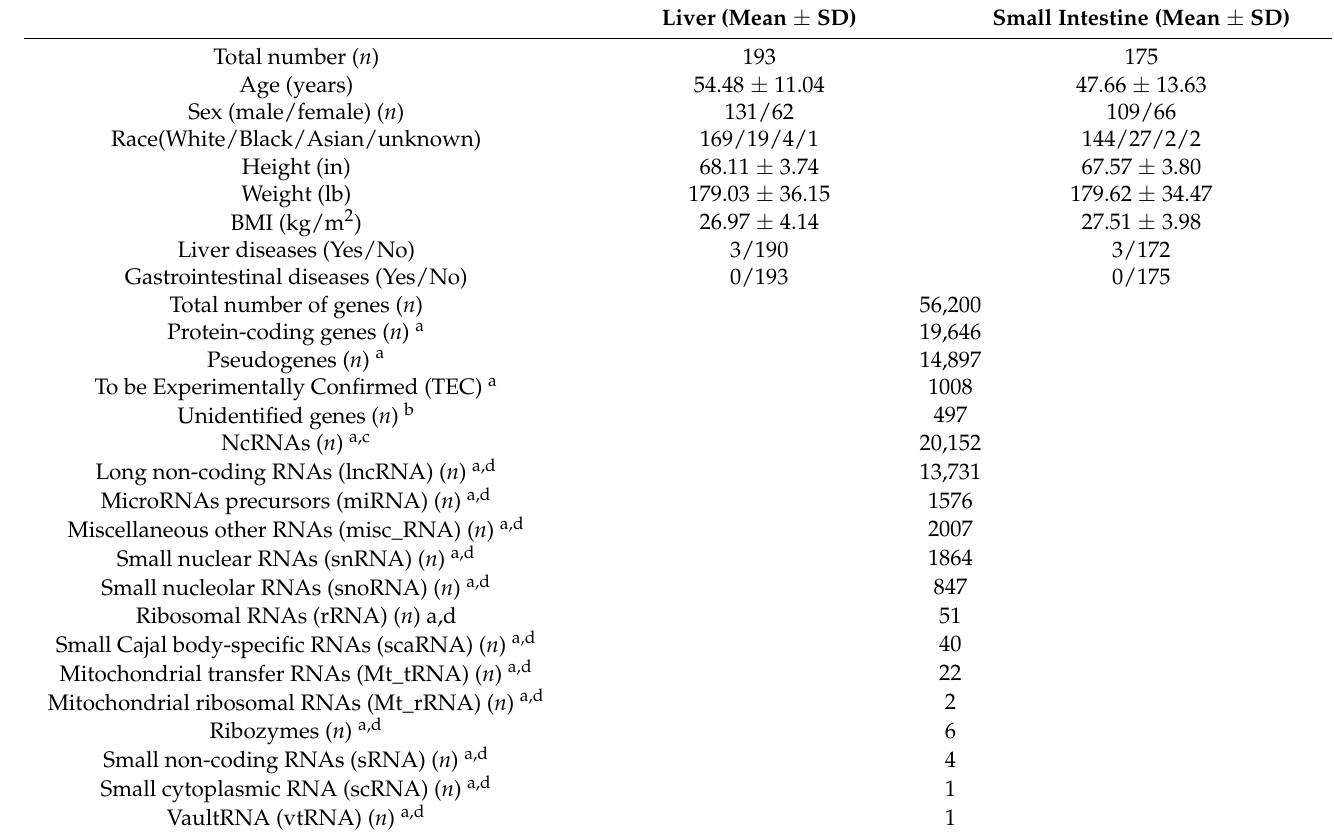
Table 1. Demographics and gene types of the liver and small intestine samples in GTEx v8 dataset. Liver (Mean ± SD) Small Intestine (Mean ±